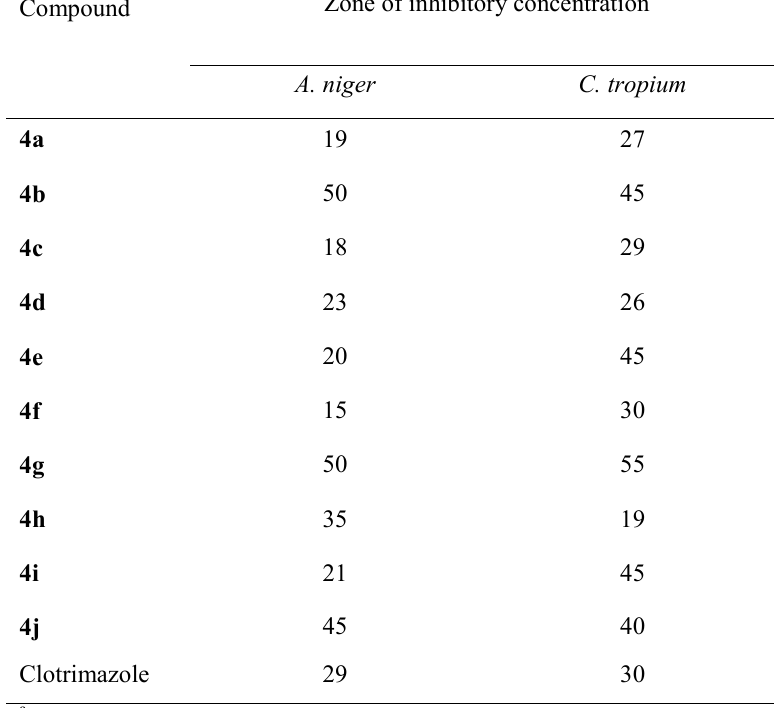
Table 4 . Antifungal activity of